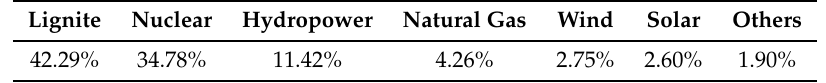
Table 4. Percentage of resources used during peak and off-peak hours in Bulgaria